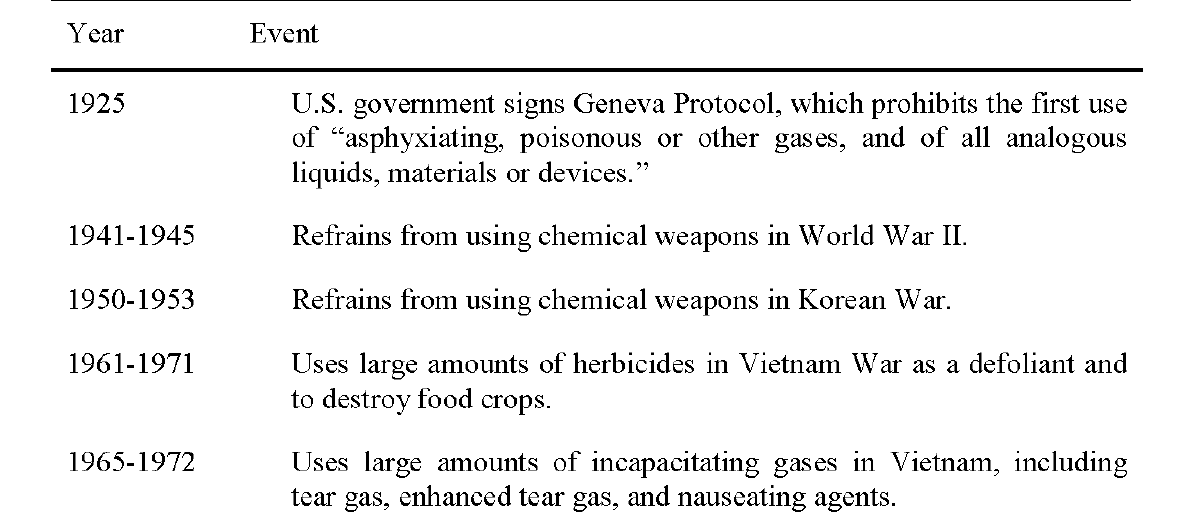
Table 1: U.S. Policy on Toxic